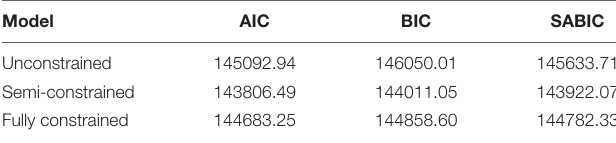
TABLE 4 | Fit indices for multi-group LPA